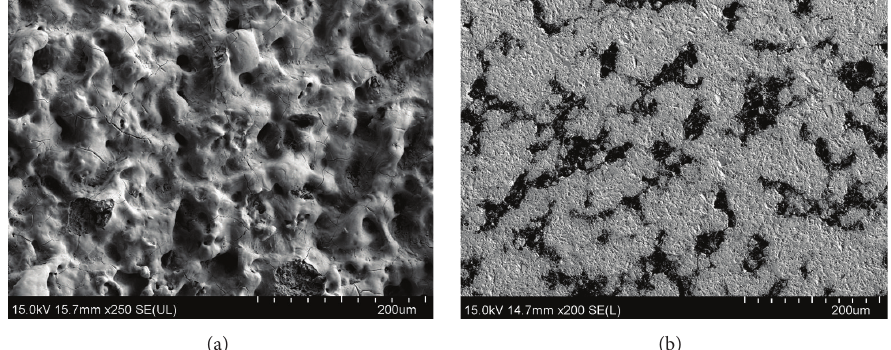
Figure 7: SEM microphotographs: (a) ablated target surface and (b) cross section of not yet ablated target